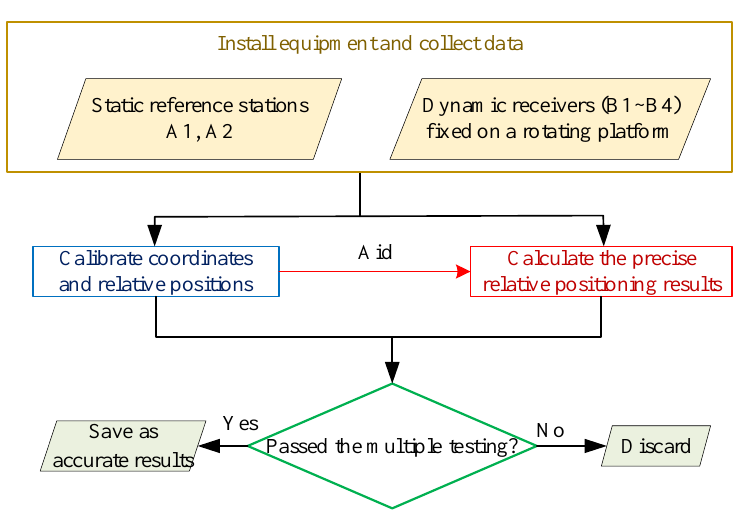
Figure 1. The main experimental steps (A means static antennae, B means dynamic antennae).